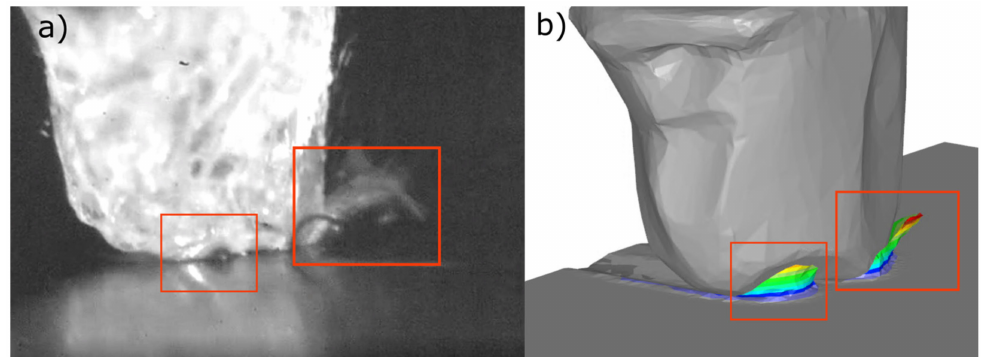
Figure 11. Frame from the high-speed camera ( a ) and the simulation process ( b ) as a part of the validation method.